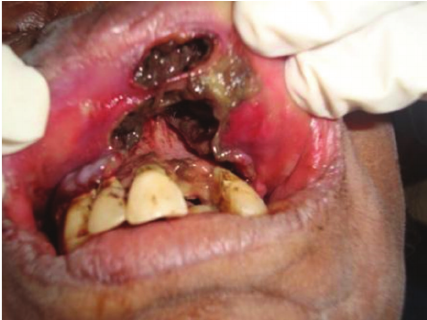
Figure 2: Intraoral photograph revealing necrosis involving labial vestibule and mucosal surface of upper lip.